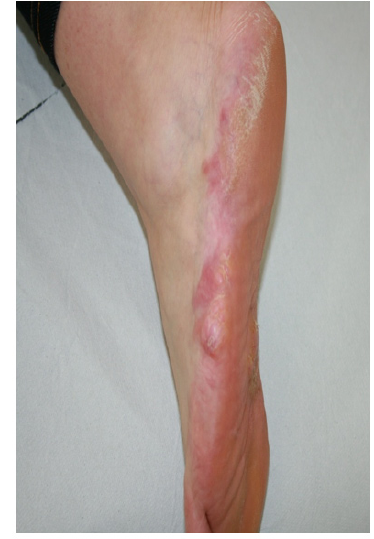
Figure 2. Proteus syndrome: Lateral view of the affected